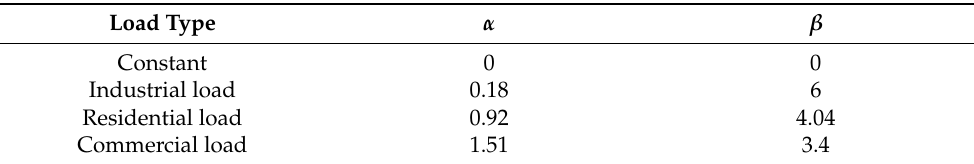
Table 1. Load types and exponent values.